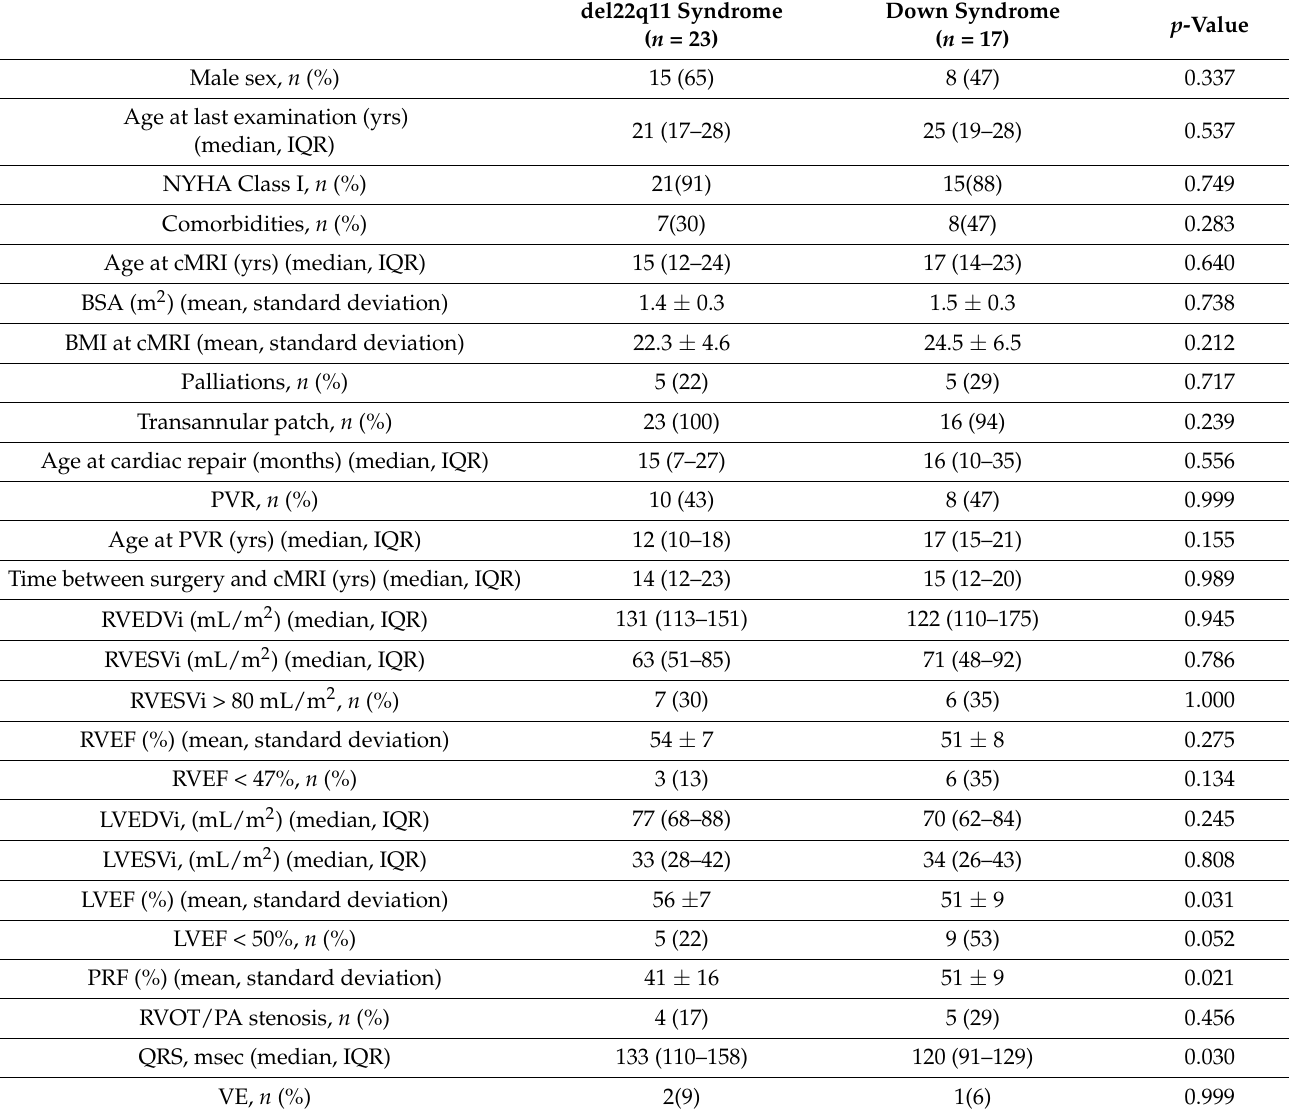
Legend Table 2: BMI: body mass index; BSA: body surface area; cMRI: cardiac magnetic resonance imaging; comorbidities: obesity, hypertension, thyroid dysfunction; LVEDVi: indexed left ventricular end-diastolic volume; LVEF: left ventricular ejection fraction; LVESVi: indexed left ventricular end-systolic volume; NYHA: New York Heart Association Functional Classification; PRF: pulmonary regurgitation fraction; PVR: pulmonary valve replacement; RVEDVi: indexed right ventricular end-diastolic volume; RVEF: right ventricular ejection fraction; RVESVi: indexed right ventricular end-systolic volume; RVOT/PA: right ventricular outflow tract/pulmonary artery; VE: ventricular events. Data are presented as frequencies and percentages, mean ± standard deviation, or median and interquartile range, as